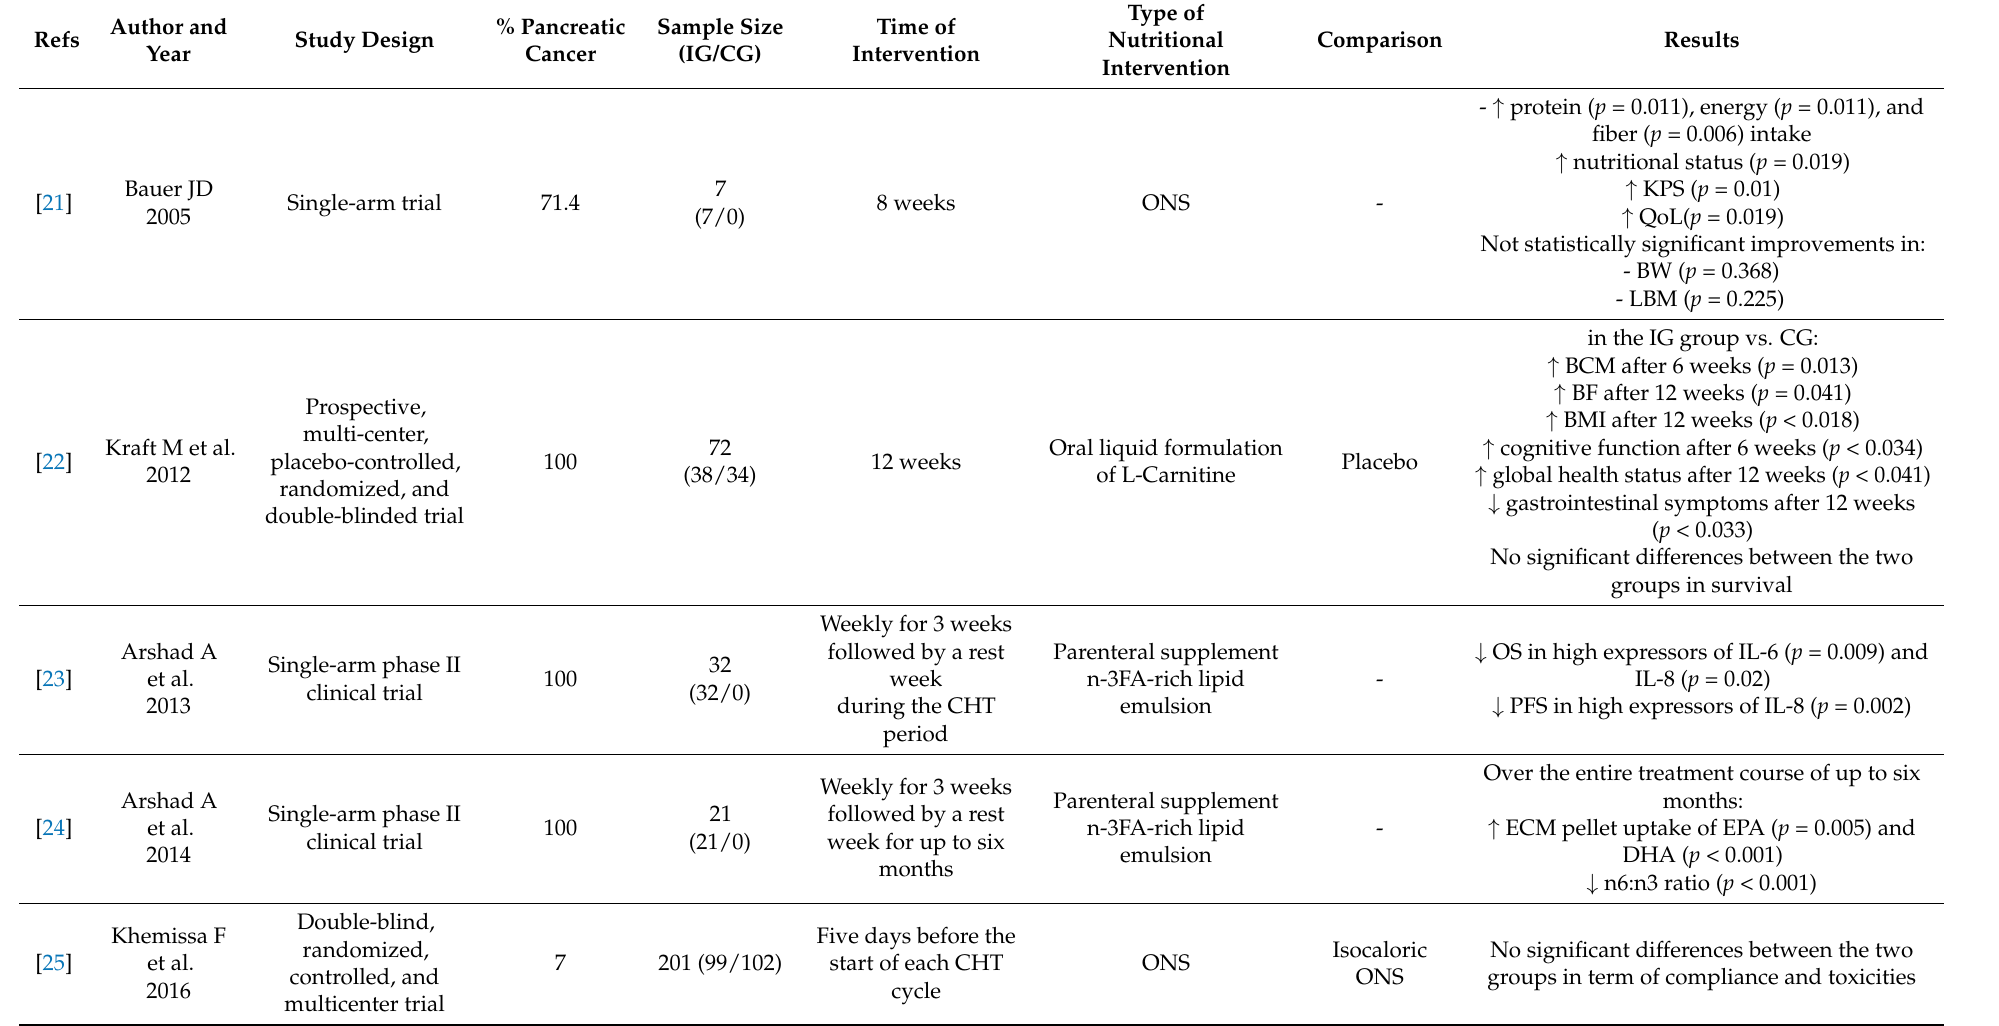
Table 1. Main characteristics of included